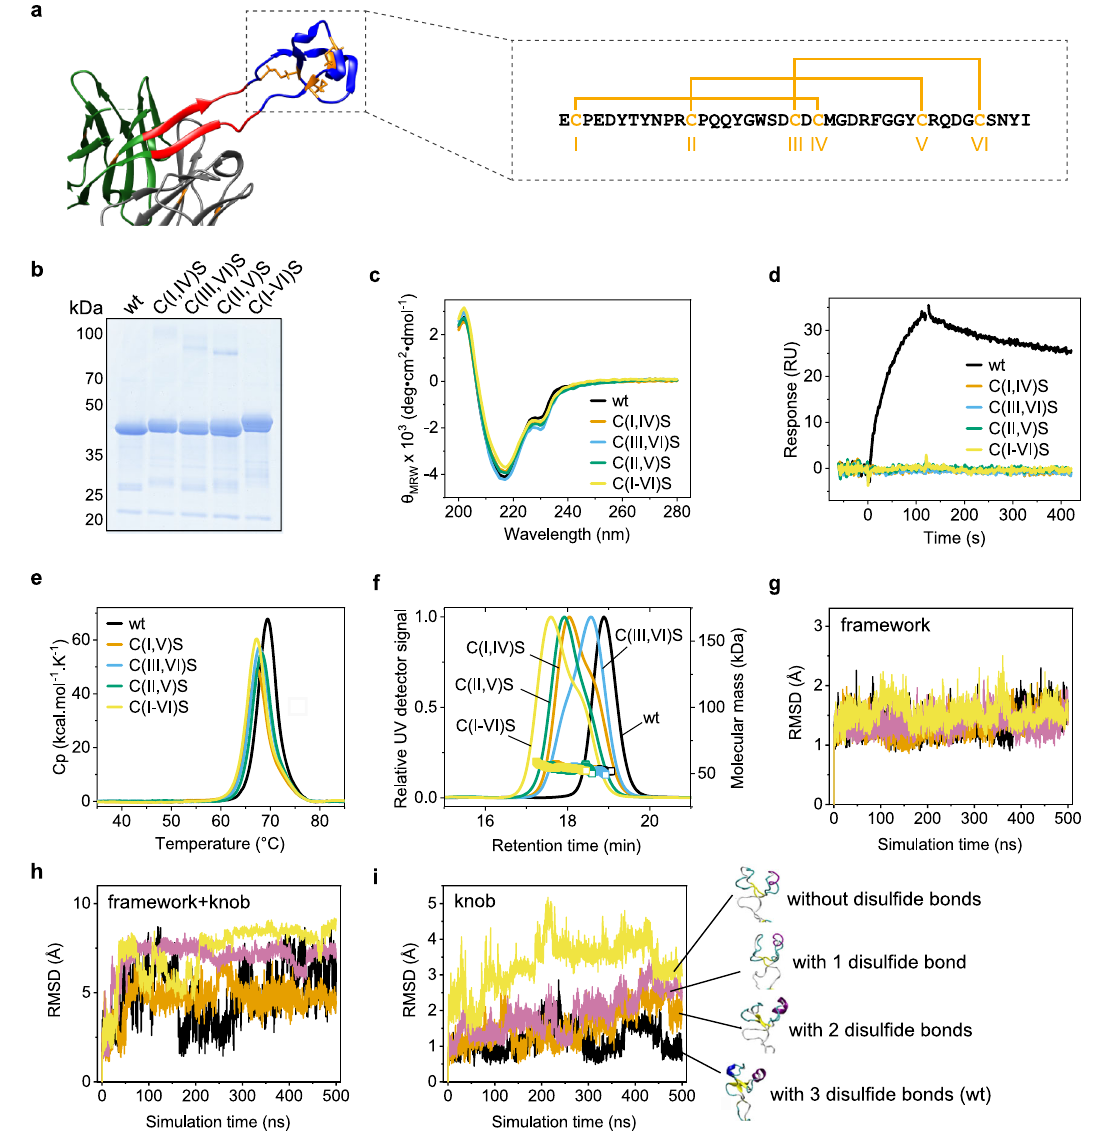
Fig. 2 Role of the disul fi de bonds in the knob. a Cysteines and disul fi de bond pattern in the knob NC-Cow1 (PDB:6OO0). b Immunoprecipitation of Expi293 supernatants after transient expression of Fab fragments followed by SDS-PAGE. Two independent experiments. c FUV CD spectra of the NC- Cow1 Fab wt compared to C → S mutants. d Binding of 100 nM NC-Cow1 Fab variants to immobilized HIV-1 Env protein in SPR. e Thermal unfolding of the NC-Cow1 Fab wt and mutants measured with DSC. f Molecular mass and eluting peaks of NC-Cow1 Fab wt and C → S mutants in SEC MALS. In c , d , e and f , black is the wildtype (wt) NC-Cow1 Fab, the remaining colors represent different NC-Cow1 Fab mutants with cysteine residues replaced by serine residues in the knob. Refer to a for the exact position of the mutations. g , h and i Comparative MD simulations of the Fv of NC-Cow1 wt (black) and variants with two (orange), one (magenta) or no (yellow) disul fi de bonds in the knob. RMSD for the g framework, h the whole structure (knob plus the framework) and i the knob itself. A snapshot of the fi nally sampled knob structure is